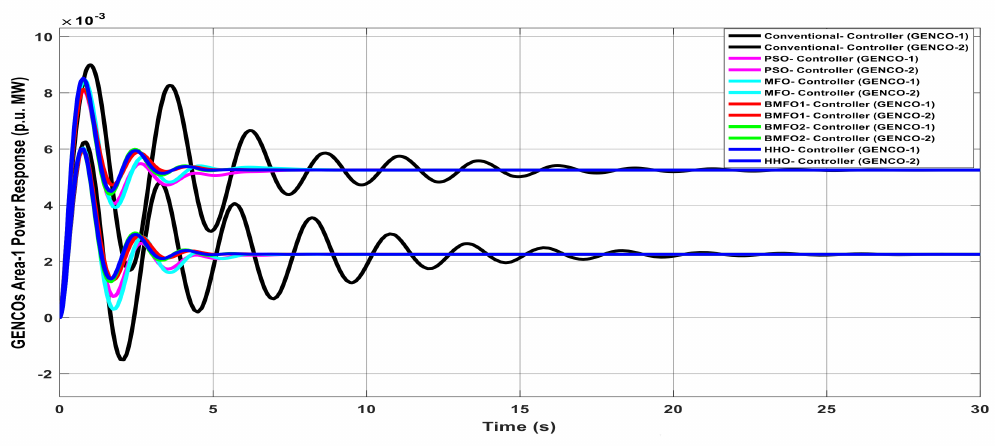
Figure 19. GENCOs generation response of Area1 with various controllers under contract violation case.